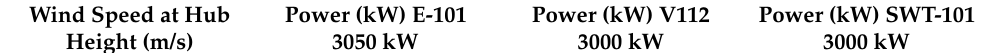
Table 2. Power curve of each wind